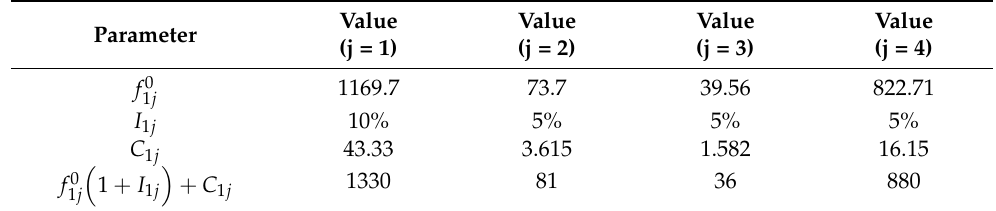
Table 4. Planning of feasible